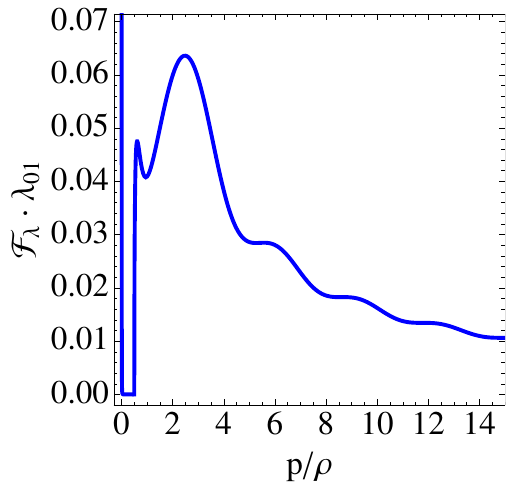
Figure 8 . The UV-to-IR brane contribution to the rescaled 4D spectral function: F λ · λ 01 ( p ) . We have used A 1 = 35 and assume time-like momenta p 2 > 0